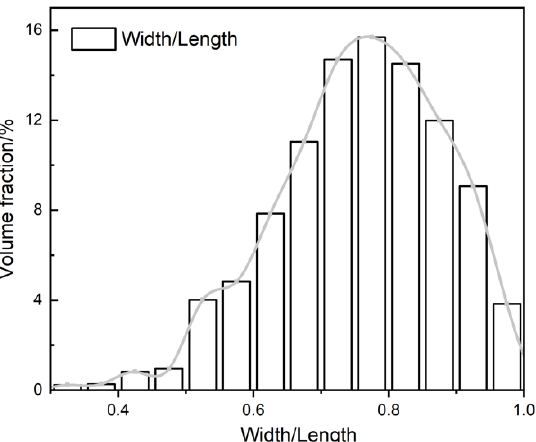
Figure 10. Volume-based distribution histogram for the elongation index, EI